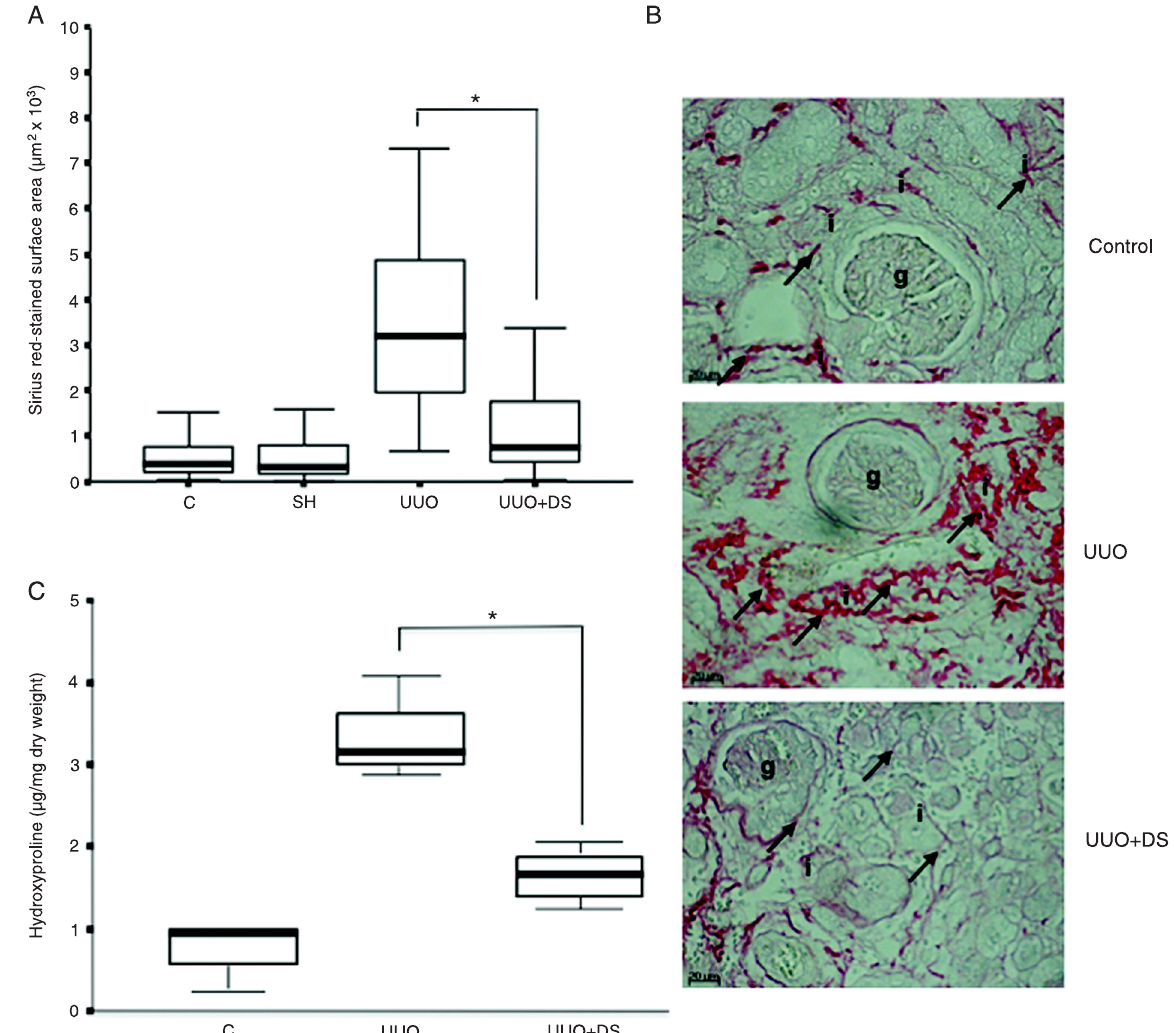
Figure 2. Collagen content in kidneys from mice submitted to different treatments. A , Histomorphometry of Sirius red-stained sections of kidneys of mice from groups C (control kidney), SH (sham-operated kidney), unilateral ureteral obstruction (UUO, obstructed kidney with no treatment), and unilateral ureteral obstruction plus dermatan sulfate (UUO+DS, obstructed kidney treated with 4 mg·kg -1 ·day -1 DS for 14 days). The horizontal bars represent the medians, boxes represent the 25th and 75th percentiles, and the vertical bars rep- resent the ranges, N = 30. B , The arrows in the UUO panel point to dense Sirius red-stained areas compared with those with reduced stained areas in control and UUO+DS panels. C , Hydroxyproline (µg/mg dry weight) was used to estimate collagen content of mouse kidneys from group C, group SH, group UUO, and group UUO+DS. The horizontal bars represent the medians, the boxes represent the 25th and 75th percentiles, and the vertical bars represent the ranges, N = 30. g = glomerulum; i = interstitium. Magnification 400X. Scale bar = 20 µm. *P < 0.05